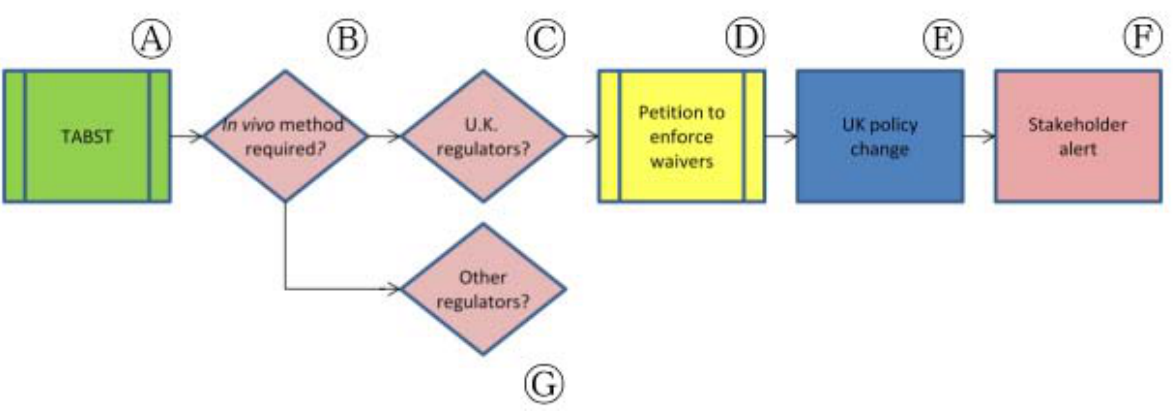
Figure 6. Application of bridging paradigm to TABST in the United Kingdom and additional